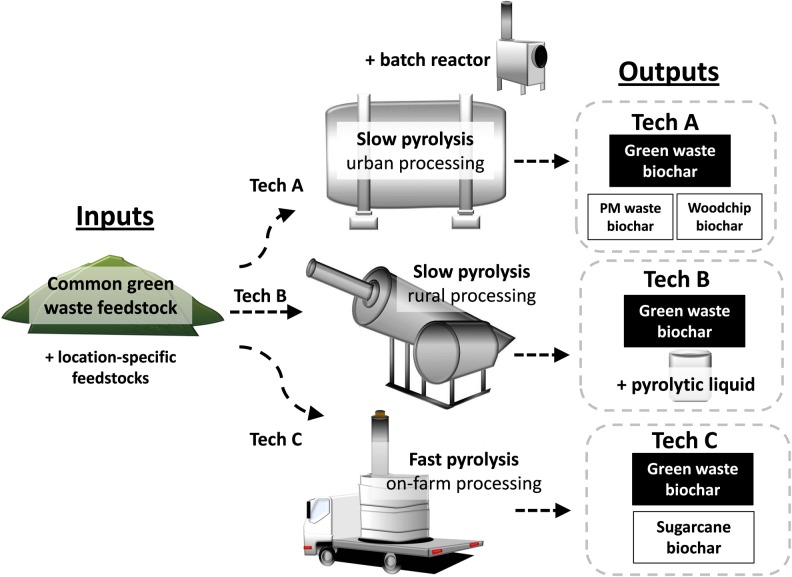
A schematic diagram of the systematic concept used for biochar manufacture.Biochars were made in sizeable quantities by three commercially operating pyrolysis technologies that included a slow pyrolyser designed for high through-put requirements (Technology A, Tech A); a slow pyrolyser for medium volume needs (Tech B) and a mobile fast pyrolyser for on-farm processing (Tech C). Six study biochars were prepared; a common green waste feedstock was made into three biochars by the commercial units, a woodchip and paper mill waste feedstock were made into biochar by a batch reactor version of Tech A (20 L capacity) and sugarcane trash was made into biochar by the commercial Tech C unit to simulate an on-farm feedstock. Additionally, a liquid bi-product was produced by Tech B.